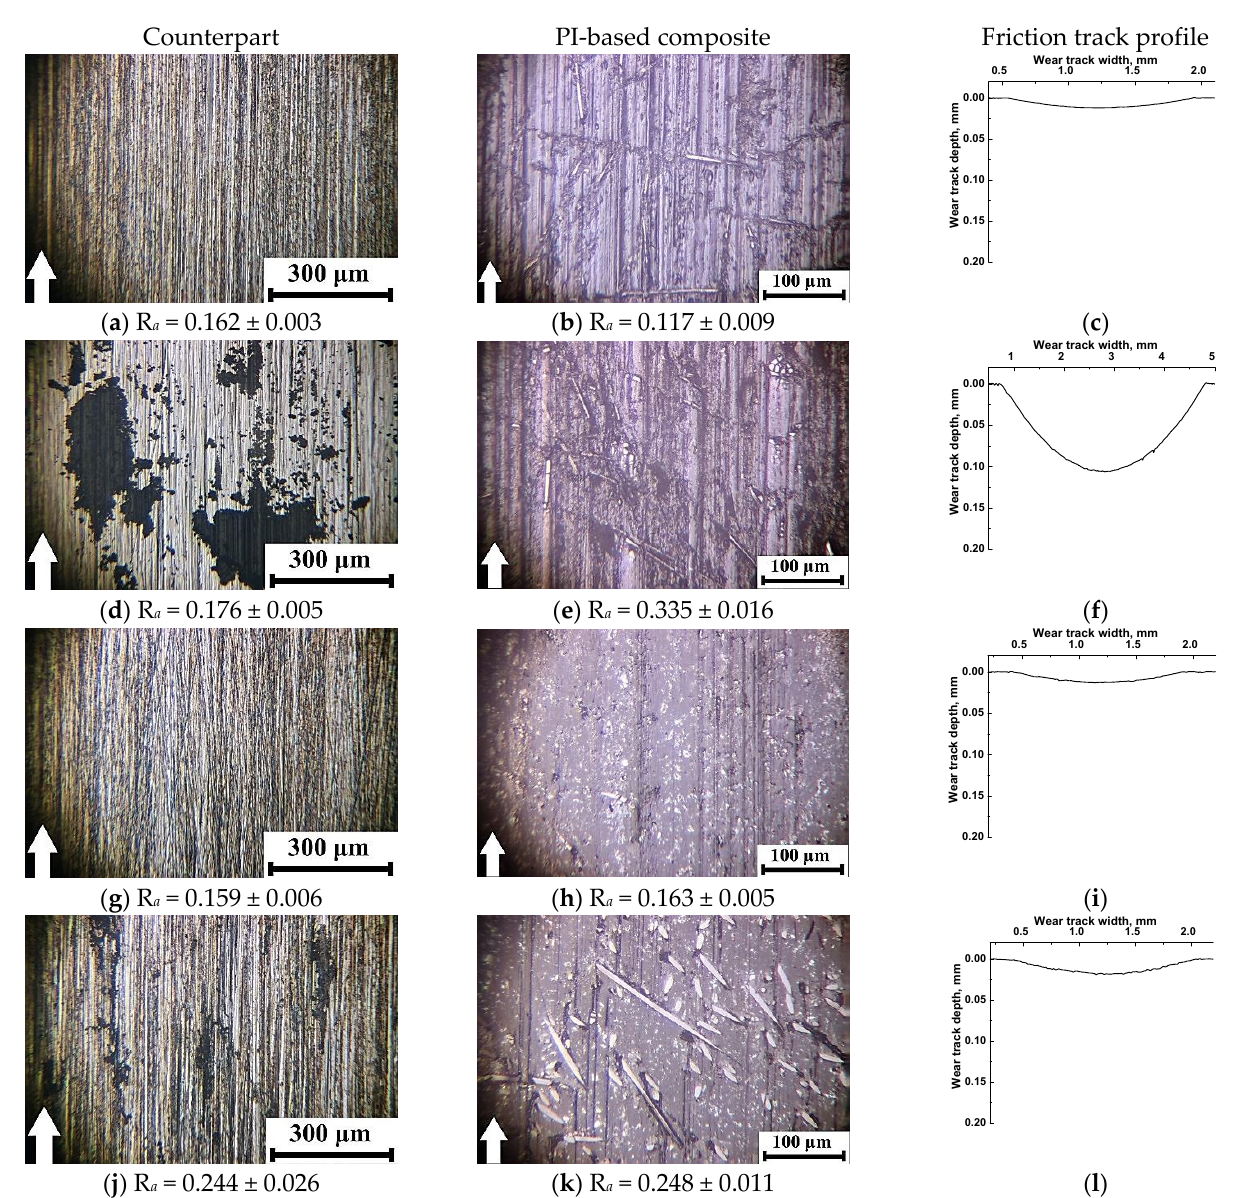
Figure 10. The micrographs of the wear tracks on the metal counterpart and the PI/10CCF ( a – c ), PI/10CCF/10PTFE ( d – f ), PI/10CCF/10Gr ( g – i ), and PI/10CCF/10MoS 2 ( j – l ) composites. The ‘mild’ mode ( P = 60 N; V = 0.3 m/s).